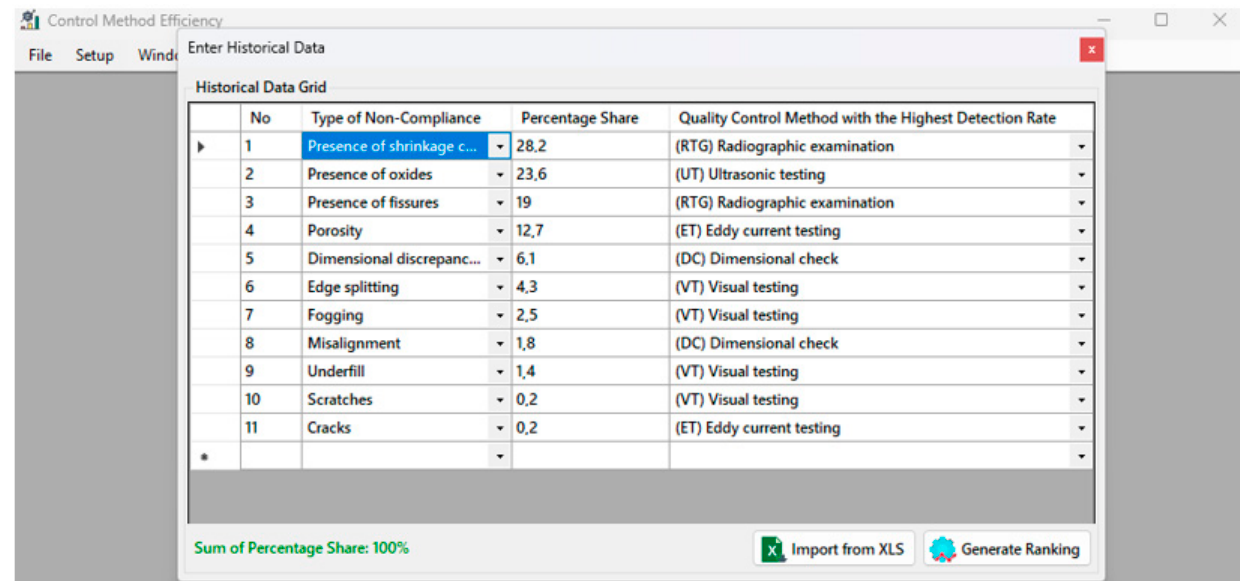
Figure 5. Identification of the 11 most commonly identified inconsistencies in electrical connector casting.